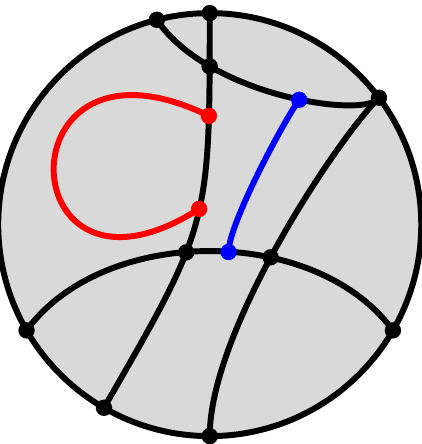
Figure 4. The red edge lies between two different new vertices on the same edge, while the blue one lies between two new vertices belonging on two different edges.